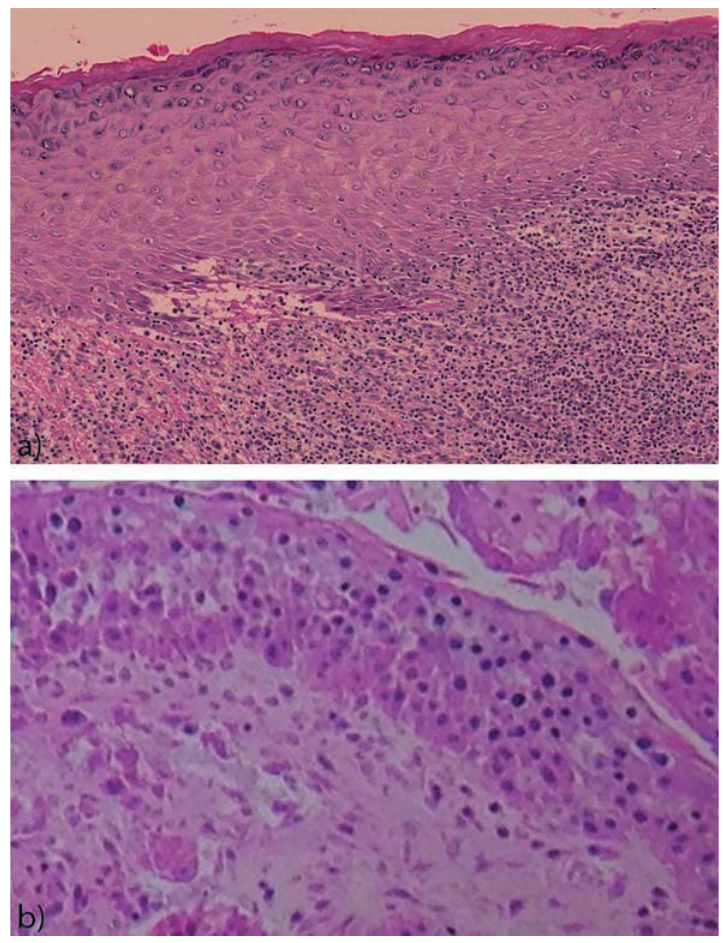
Figure 2- (cid:2)(cid:3)(cid:4)(cid:5)(cid:6)(cid:7)(cid:8)(cid:7)(cid:9)(cid:4)(cid:10)(cid:11)(cid:8)(cid:2)(cid:11)(cid:12)(cid:12)(cid:13)(cid:11)(cid:14)(cid:11)(cid:15)(cid:10)(cid:13)(cid:2)(cid:16)(cid:3)(cid:13)(cid:17)(cid:11)(cid:6)(cid:7)(cid:18)(cid:19)(cid:8)(cid:4)(cid:15)(cid:2)(cid:20)(cid:2)(cid:13)(cid:7)(cid:5)(cid:4)(cid:15)(cid:21)(cid:2)(cid:22)(cid:23)(cid:23)(cid:24)(cid:2)(cid:25)(cid:11)(cid:26)(cid:21)(cid:2)(cid:27)(cid:23)(cid:23)(cid:24)(cid:2)(cid:25)(cid:28)(cid:26)(cid:29)(cid:30)(cid:2)(cid:11)(cid:26)(cid:2)(cid:28)(cid:11)(cid:15)(cid:31)!(cid:8)(cid:4)"(cid:13)(cid:2)(cid:8)(cid:19)(cid:17)(cid:12)#(cid:7)(cid:10)(cid:19)(cid:6)(cid:4)(cid:10)(cid:2)(cid:4)(cid:15)$(cid:8)(cid:6)(cid:14)(cid:11)(cid:6)(cid:13)(cid:2)(cid:4)(cid:15)(cid:2)(cid:6)#(cid:13)(cid:2) lichenoid area; b) Carcinoma in situ showing several changes from basal layer to upper layer of epithelium. The following alterations are present: cells with enlarged nuclei, pleomorphic cells, hyperchromatism, increased nuclear-to-cytoplasmic